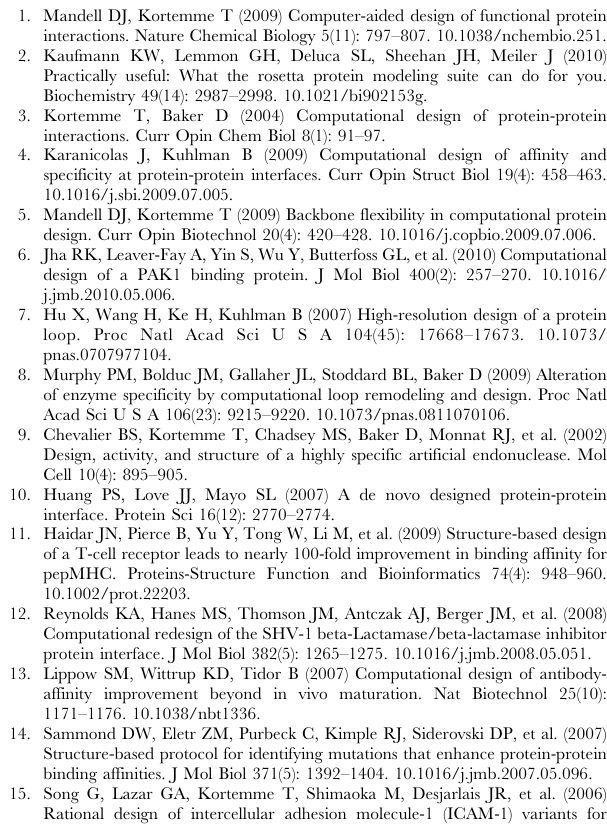
Figure S5 2obg and 1fc4 sampling. This image shows the range of sampling in 100 convenience-sample result structures from the standard protocol. Panel A contains 100 predictions for PDB 2obg, and panel B contains the correct 2obg structure for comparison. Panels C and D contain the same for the 1fc4 system. In each panel, the fixed side of the interface is at the bottom in green and the spread of possible docking orientations are across the top in a rainbow of colors. It can be seen that many possible interfaces and rigid body degrees of freedom are sampled. Furthermore, this sample represents result structures; many more orientations are sampled within a trajectory but rejected by Monte Carlo or superseded by better structures. Table S1 AnchoredDesign scorefunction. This table lists the Rosetta scorefunction terms used in the benchmarking experiments for AnchoredDesign. All terms and weights except chainbreak are the standard Score12 terms used for many Rosetta experiments. Chainbreak is used with CCD loop modeling; the weight of 2 was determined empirically and can be modified by an AnchoredDesign command line flag.